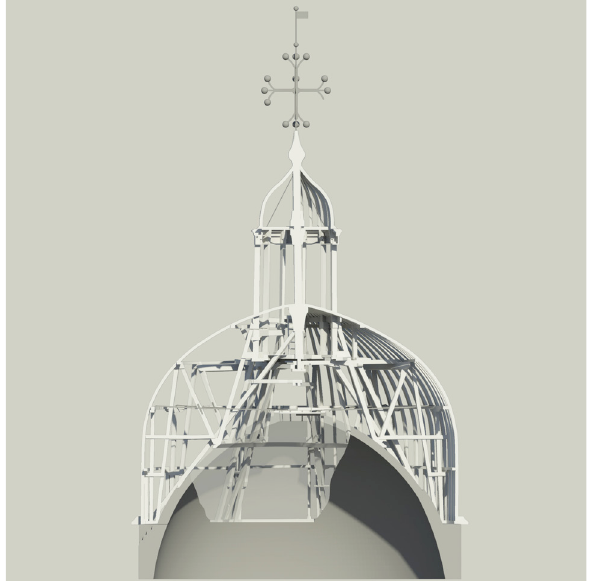
Figure 12. Image of a section of the 3D model made with